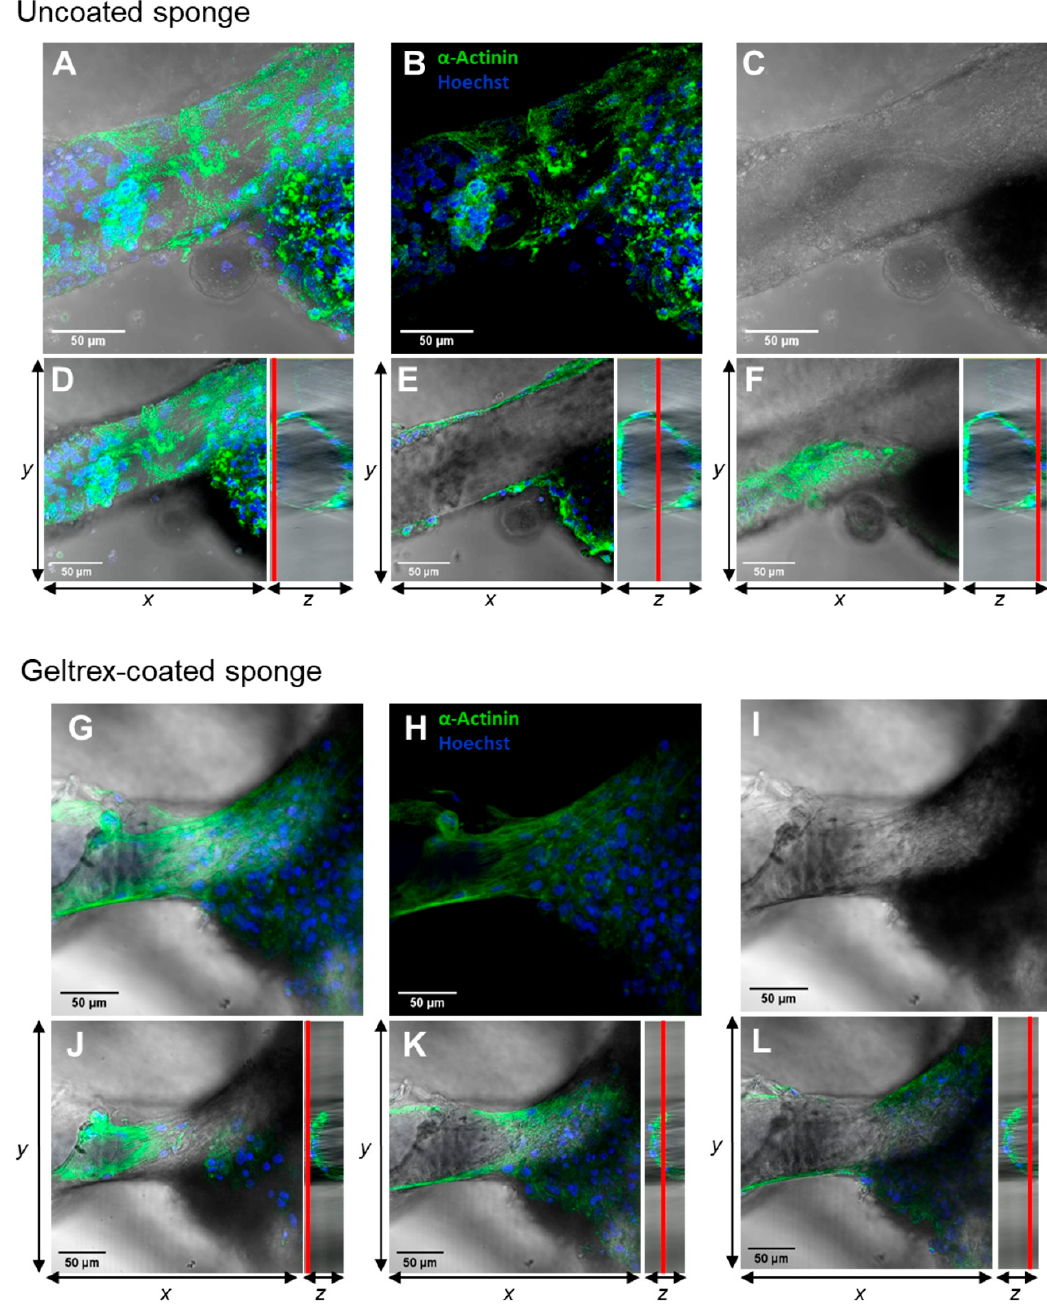
Figure 10. Documentation of iPSC-CM attachment using fluorescence microscopy. Images of iPSC-CMs on I. labyrinthus chitin sca ff olds (marked as “sponge”) have been obtained as z-stacks of 90–250 images using confocal laser scanning microscopy. ( A – C , G – I ) Combined images of all z-stacks in this area. ( D – F , J – L ) Combined images of di ff erent z-positions indicated by the red line in yz-plots.